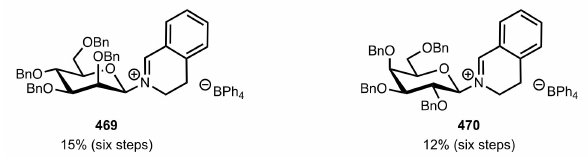
Figure 32. The sugar iminium organocatalysts 469 and 470